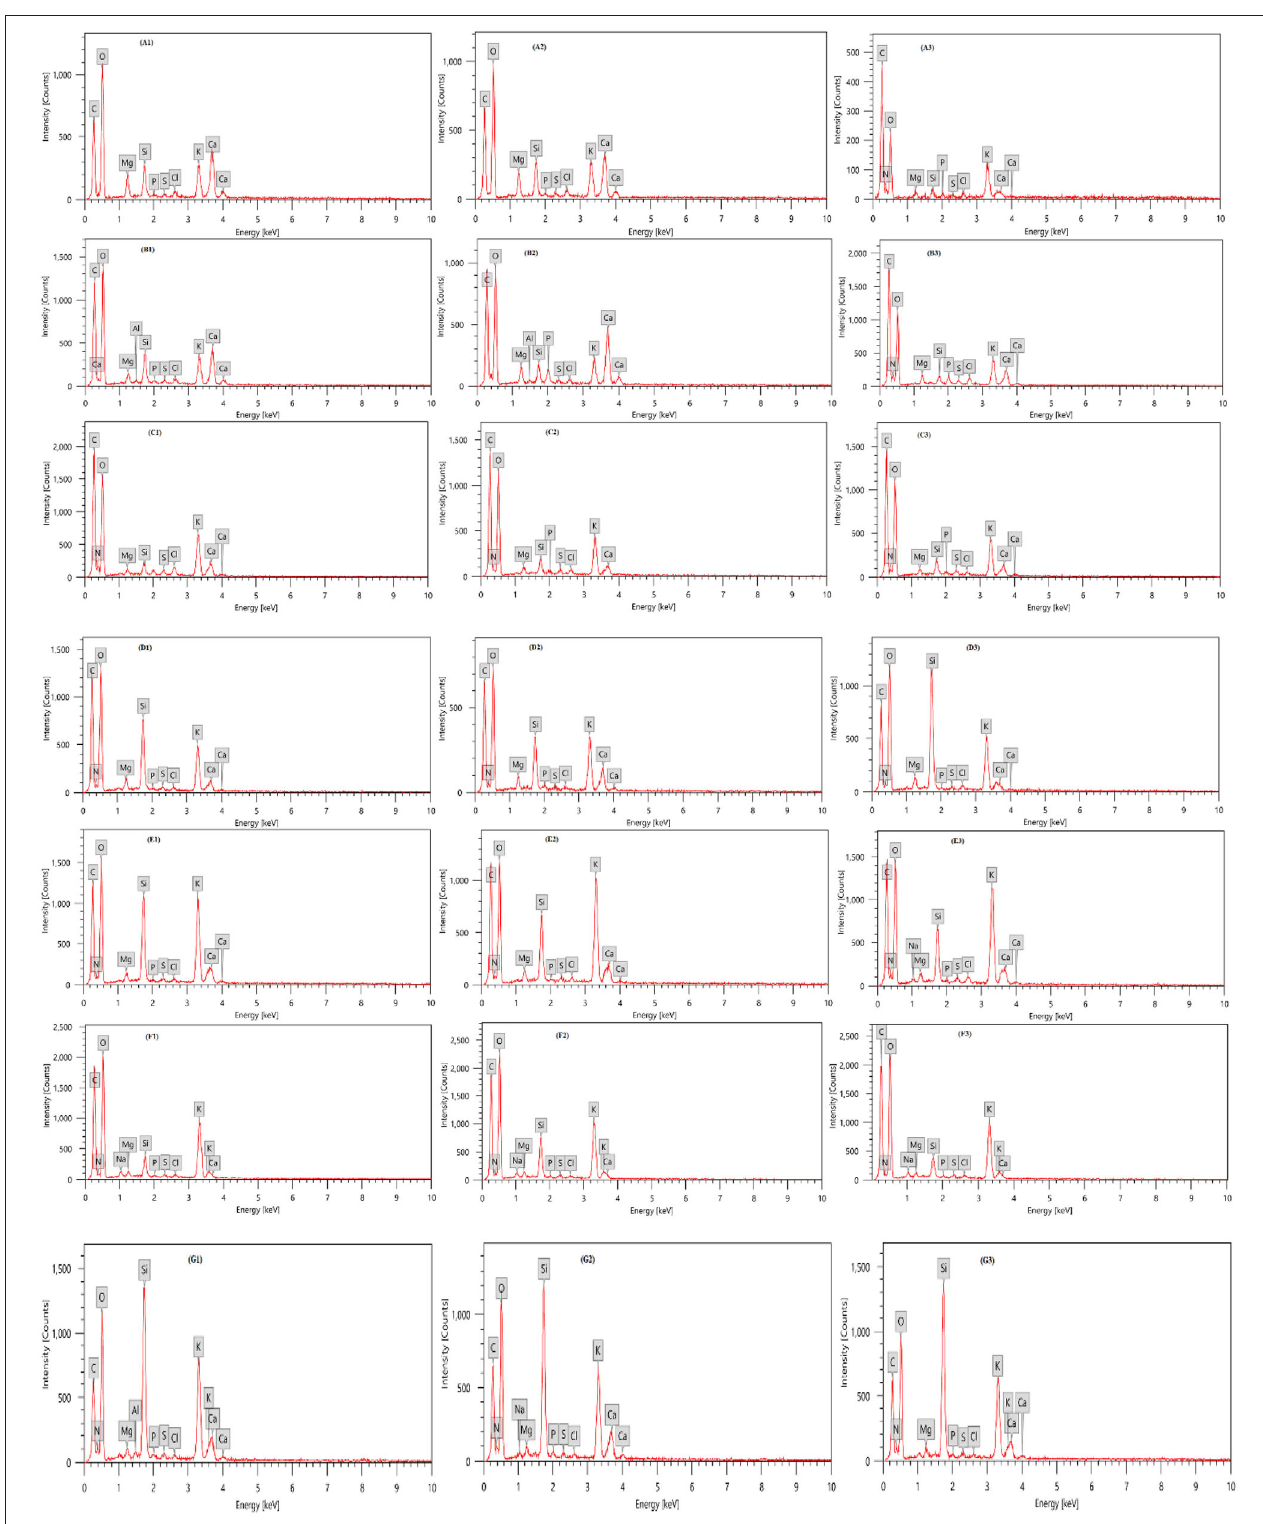
FIGURE 3 | Elemental compositions of zucchini leaves with EDX analysis as affected by plant extracts, microbial inoculations, and potassium silicates biostimulants. Analysis was taken from three points for each treatment. (A1–A3) Control; (B1–B3) T. viride + K 2 SiO 3 ; (C1–C3) P. fluorescens + K 2 SiO 3 ; (D1–D3) T. viride + P. fluorescens + K 2 SiO 3 ; (E1–E3) E. camaldulensis LE + K 2 SiO 3 ; (F1–F3) C. sinensis LE + K 2 SiO 3 ; (G1–G3) F. benghalensis FE + K 2 SiO 3 .